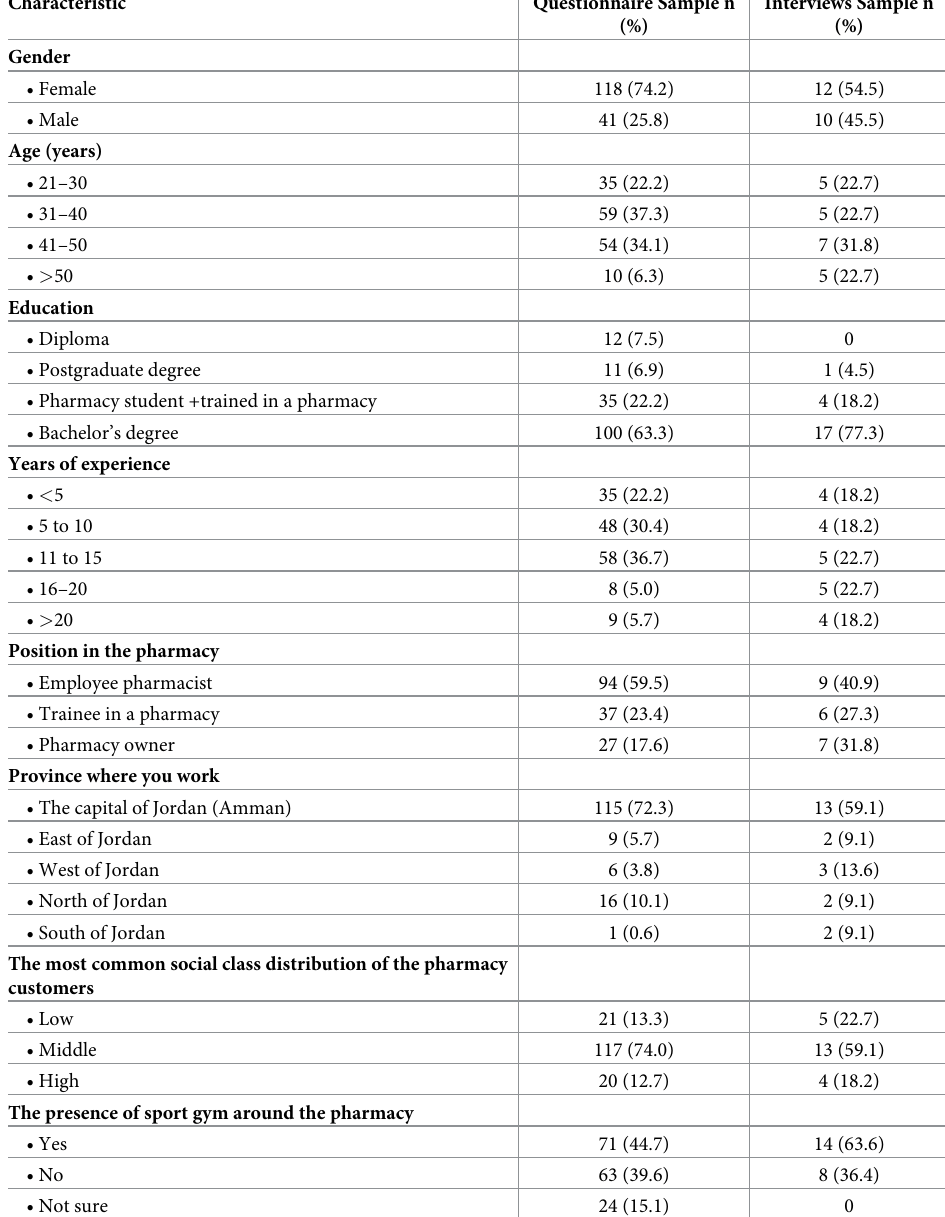
Table 1. Sociodemographic characteristics of the participants in both quantitative (n = 158) and qualitative phases (n = 22).